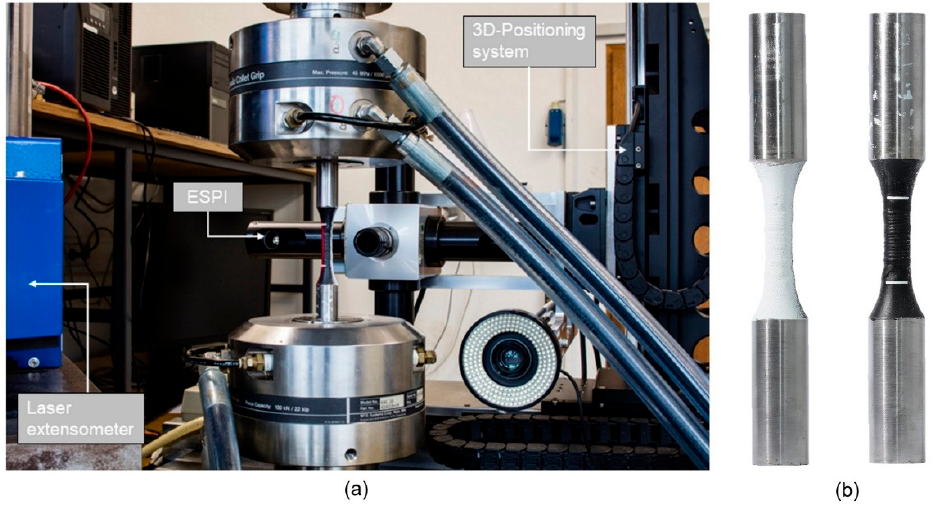
Figure 4. ( a ) Experimental setup; ( b ) specimen sprayed with lime powder (left) and black lacquer (right).